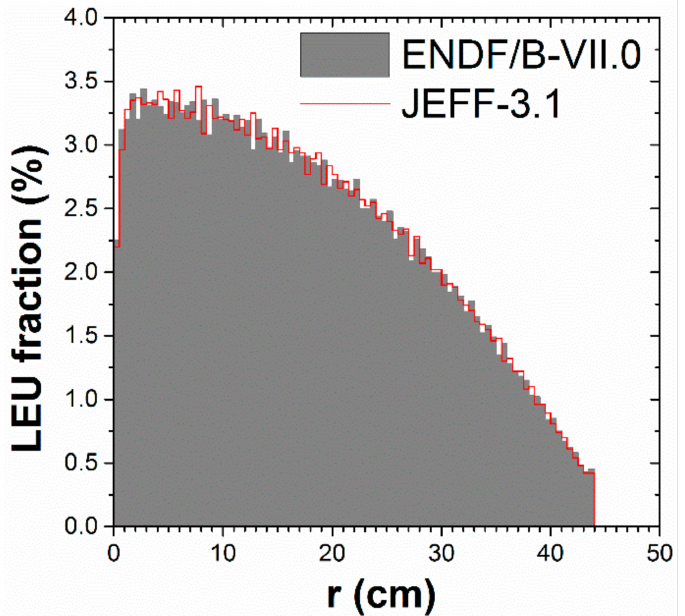
Figure 3. Optimal low-enriched uranium (LEU) fraction profile as a function of the distance r from the assembly